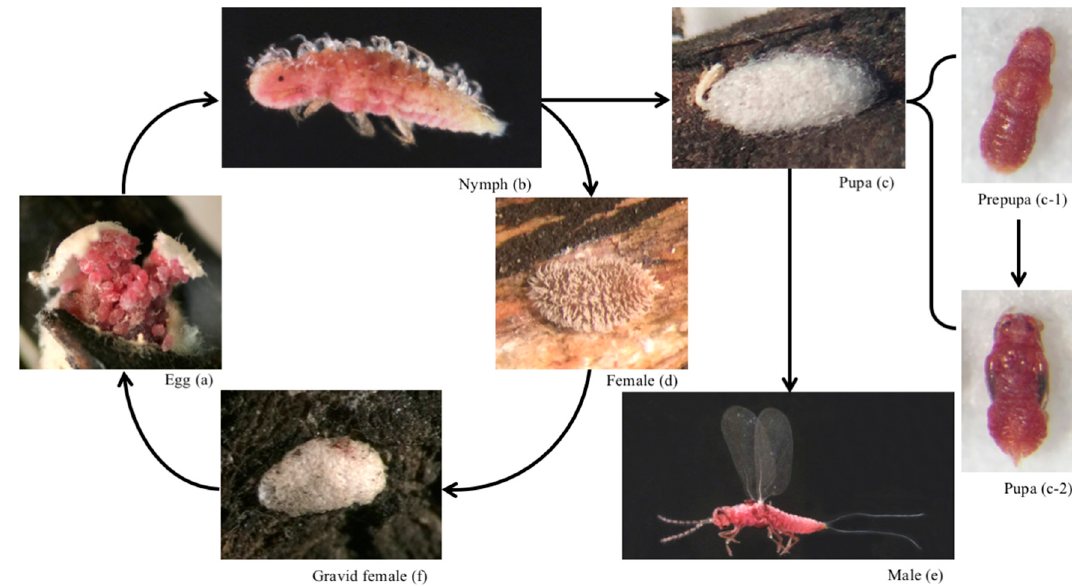
Figure 2. Life cycle of Acanthococcus lagerstroemiae : ( a ) Egg; ( b ) Nymph; ( c ) Pupa covered with white sac; ( c-1 ) Prepupa; ( c-2 ) Pupa; ( d ) Adult female; ( e ) Adult male; and ( f ) Ovisac containing the gravid adult female.